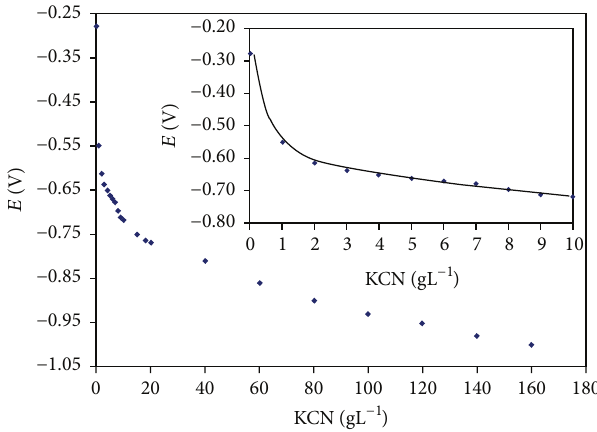
Figure 3: The effect of KCN concentration on the onset potential of silver electrodeposition. The silver plating solution consists of 120 g/L KAg(CN) 2 , 120 g/L KNO 3 , and 0–160g/L KCN. Inset: the onset potential of silver electrodeposition in the range of 0–10g/L